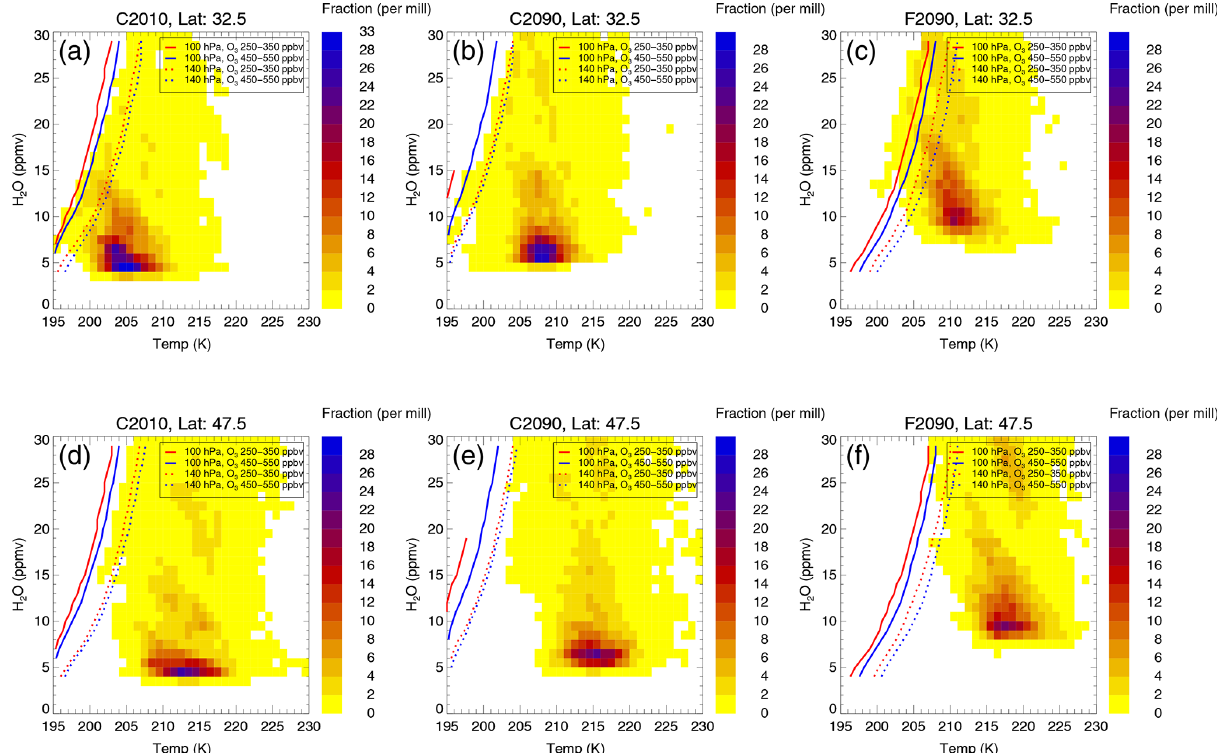
Figure 7. H 2 O–temperature relative frequency distributions and examples for chlorine activation thresholds for the cases C2010 (a, d) and the future scenarios at the end of the 21st century assuming global warming (C2090, b, e ) and additional geoengineering (F2090, c, f ) for the subtropical latitude band (30–35 ◦ N, a–c ) and the extratropical band (44–49 ◦ N, d–f ). The colour marks the fraction of the considered data corresponding to an H 2 O and temperature bin (1ppmv H 2 O × 1K). The H 2 O- and temperature-dependent chlorine activation threshold is marked as a line for exemplarily chosen data groups specified in the legend of each